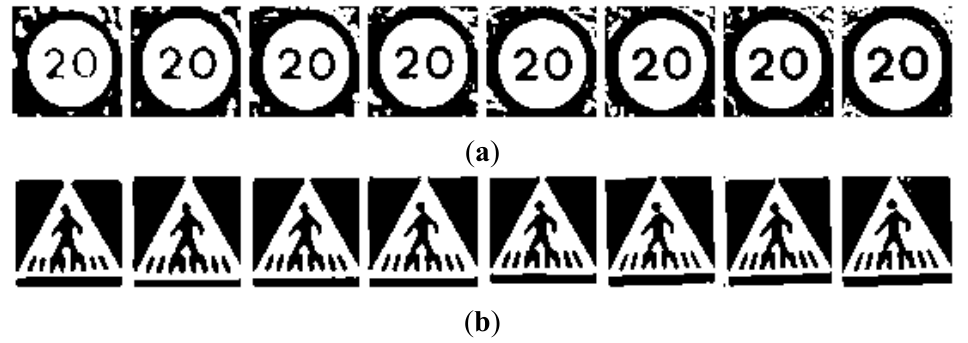
Figure 7. Examples of candidates in Figure 5 processed through a 15% thresholding P-Tile for ( a ) Red road signs. ( b ) Blue road